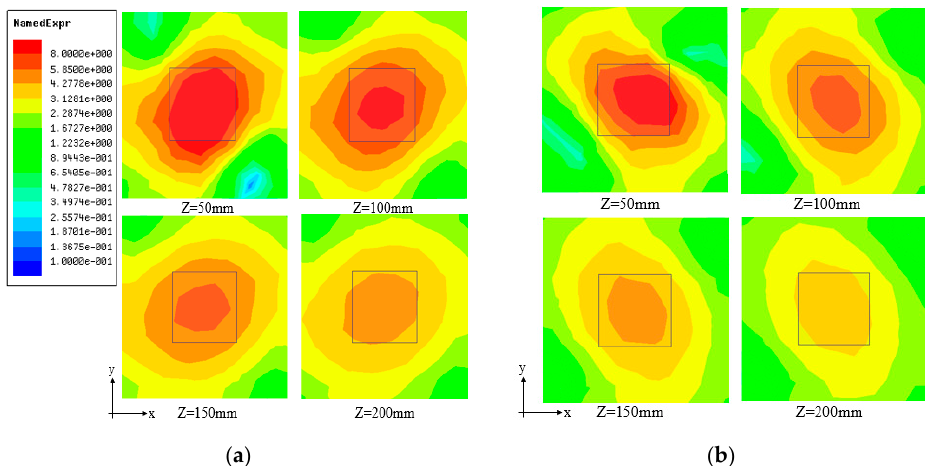
Figure 18. Distribution of simulated electric field components (Ex, Ey) at different heights when loop spacing d = 9 mm: ( a ) Ex distribution and ( b ) Ey distribution.